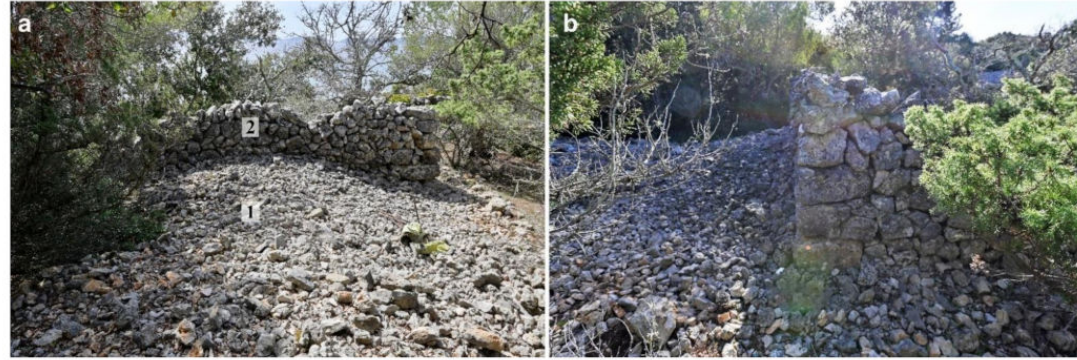
Figure 17. Stone deposit 4359 (1) is heaped up against the north face of the building (2) and therefore must be later than the construction of the building. ( a ) View direction south showing the north face of the building. ( b ) View direction east with a view of the west face of the building (Photos: M. Doneus, 13 April